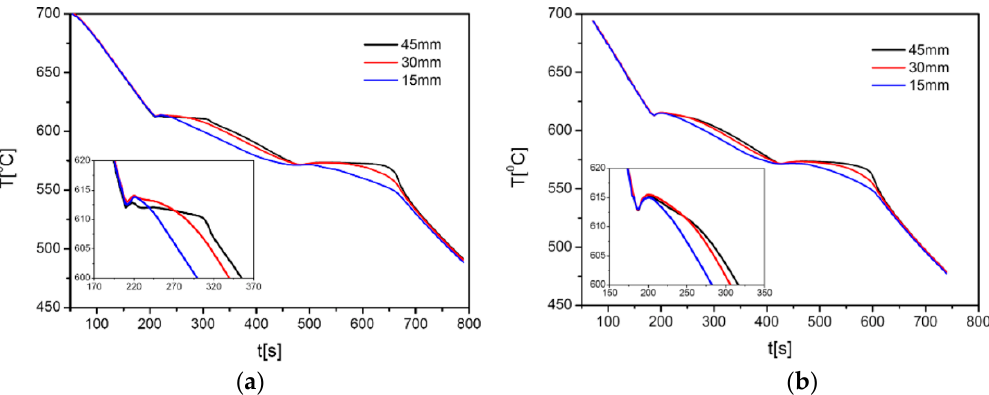
Figure 3. Cooling curves of Al ‐ 7 wt. %Si alloy solidified in the double ‐ walled mold: ( a ) with ECP; ( b ) with TMF.